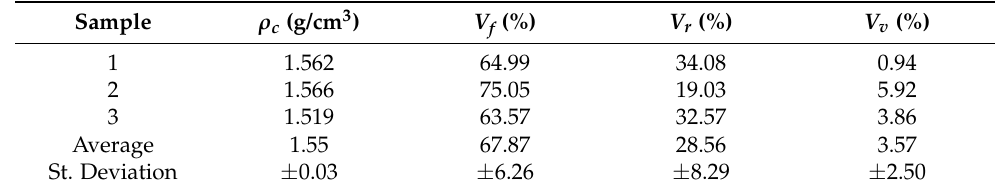
Table 2. Fibre, resin and void volume contents, and density of the composite samples obtained through the chemical digestion process.